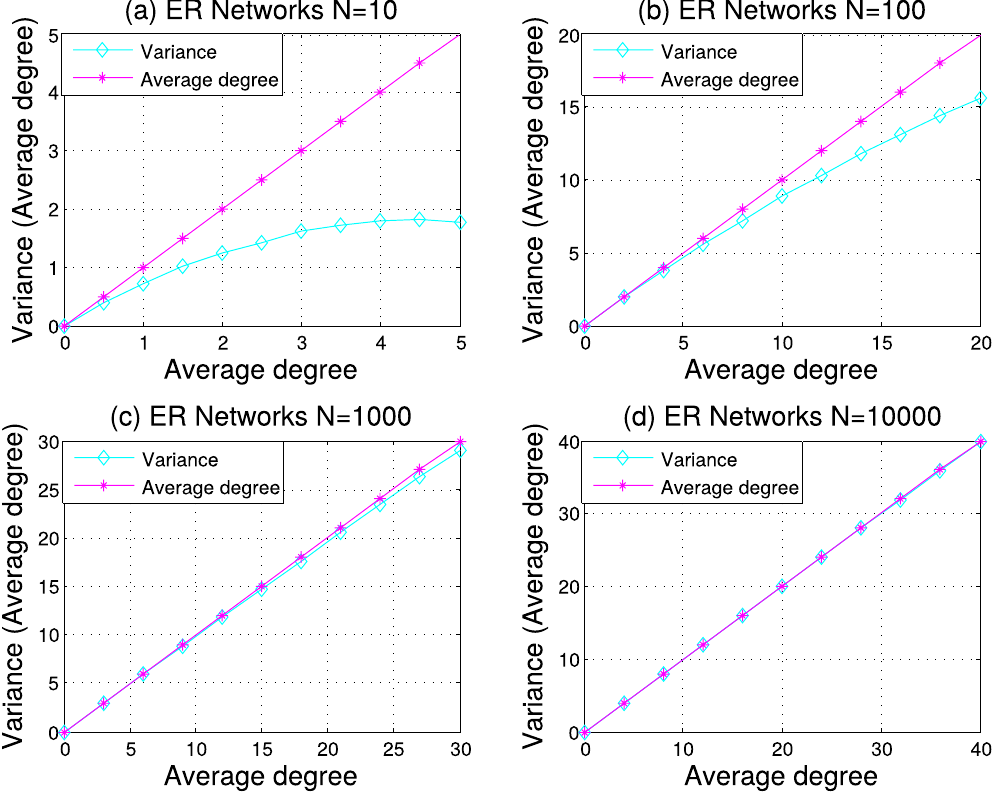
Figure 2. Approximation of the expected degree variance with the average node degree in the ER network. This experimental analysis of the relationship between the expected variance of node degrees and the average degree was done on networks of four increasing sizes, N = 10, 100, 1000 and 10,000, with the average degrees of [0.5, 1, 1.5, … , 5, [2, 4, 6, … , 20], [3, 6, 9, … , 30], and [4, 8, 12, … 40], respectively. Each data point in the figure was averaged over 1,000 random problem